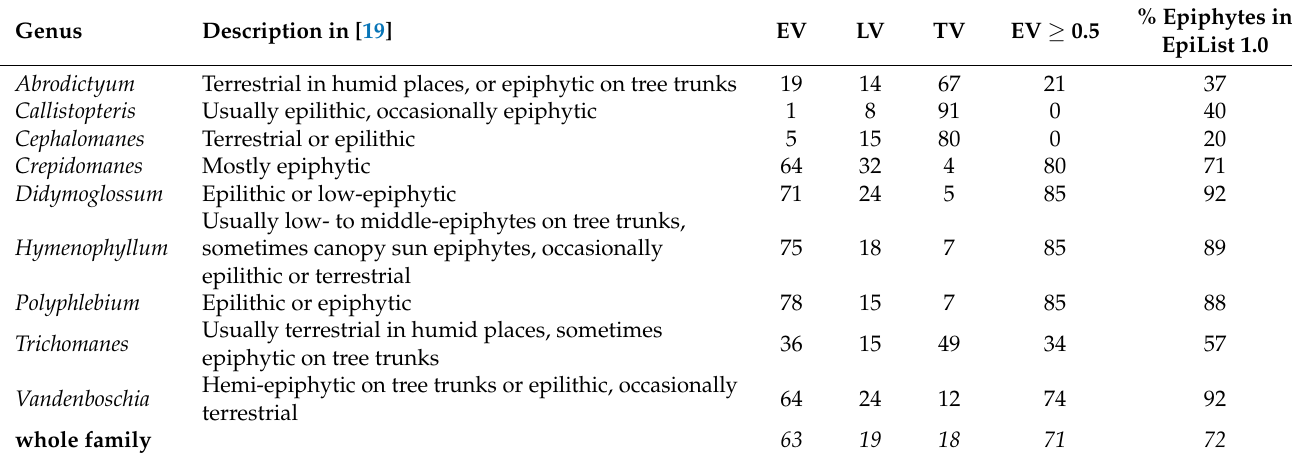
Table 2. Average values of the Epiphyte value (EV), lithophyte value (LV) and terrestrial value (TV) in the current analysis, the proportion of all species in the nine accepted genera or the family as a whole with an EV ≥ 0.5 and the proportion of epiphyte species per genus or entire family in EpiList 1.0